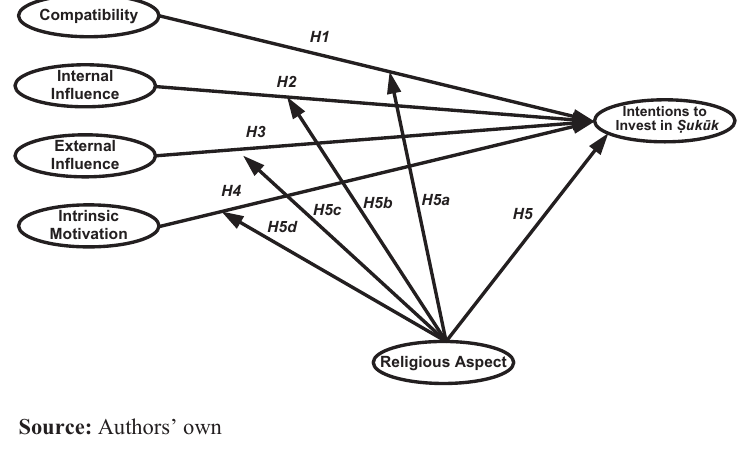
Figure 1. Conceptual